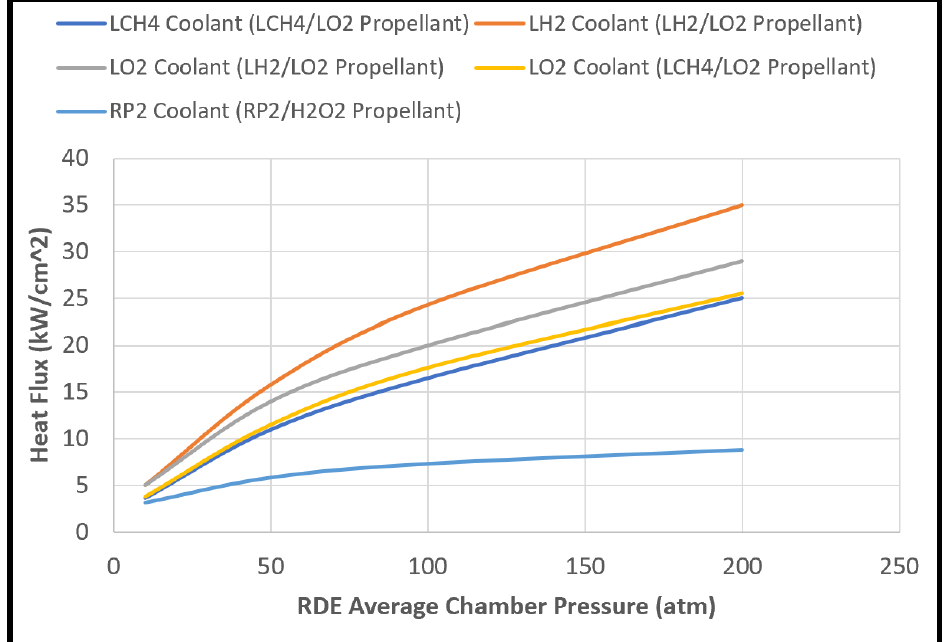
Figure 8. Predicted RDE Heat Flux for Multiple Chamber Pressures and Propellant Combinations.